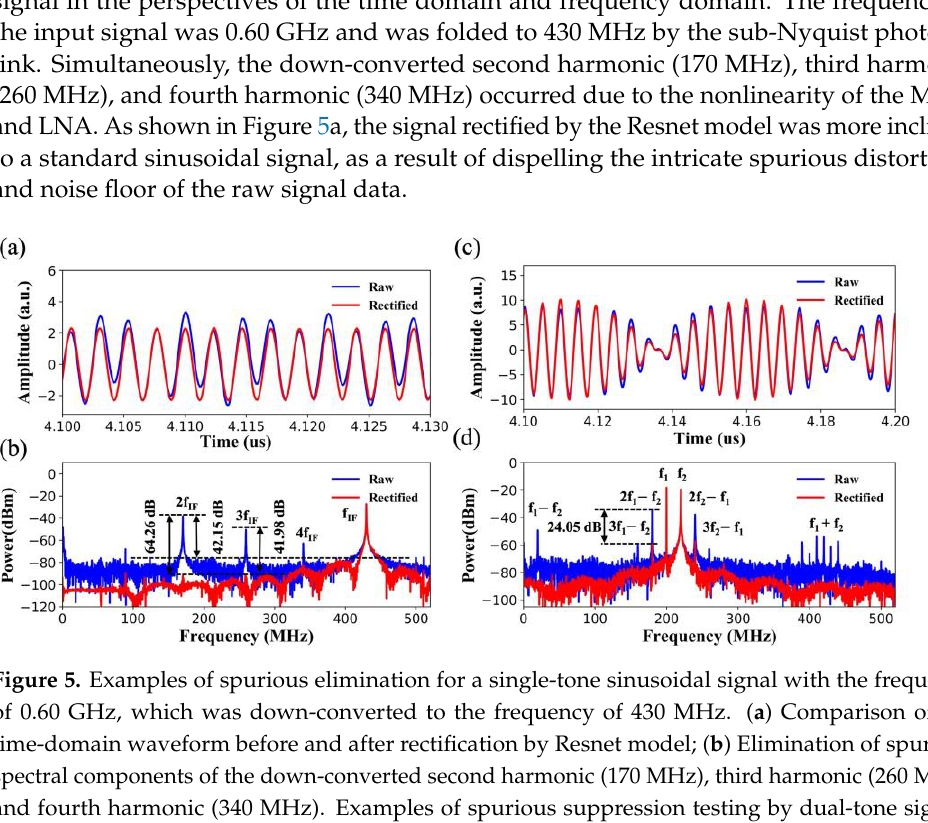
Figure 4. Effects of deep learning-based spurious elimination in the frequency domain with the in- put signal of various input power, ranging from 0 to 40 GHz. The selected displayed input frequen- cies are 0.2 GHz, 2.7 GHz, 5.8 GHz, 10.0 GHz, 14.0 GHz, 20.0 GHz, 24.5 GHz, 27.5 GHz, 32.5 GHz, and 40.0 GHz, which were all down-converted to the first Nyquist zone (0 – 515 MHz) with the frequencies of 200 MHz, 390 MHz, 380 MHz, 300 MHz, 420 MHz, 430 MHz, 220 MHz, 310 MHz, 460 MHz, and 170 MHz, respectively. N represents the Nyquist zone of each input signal.